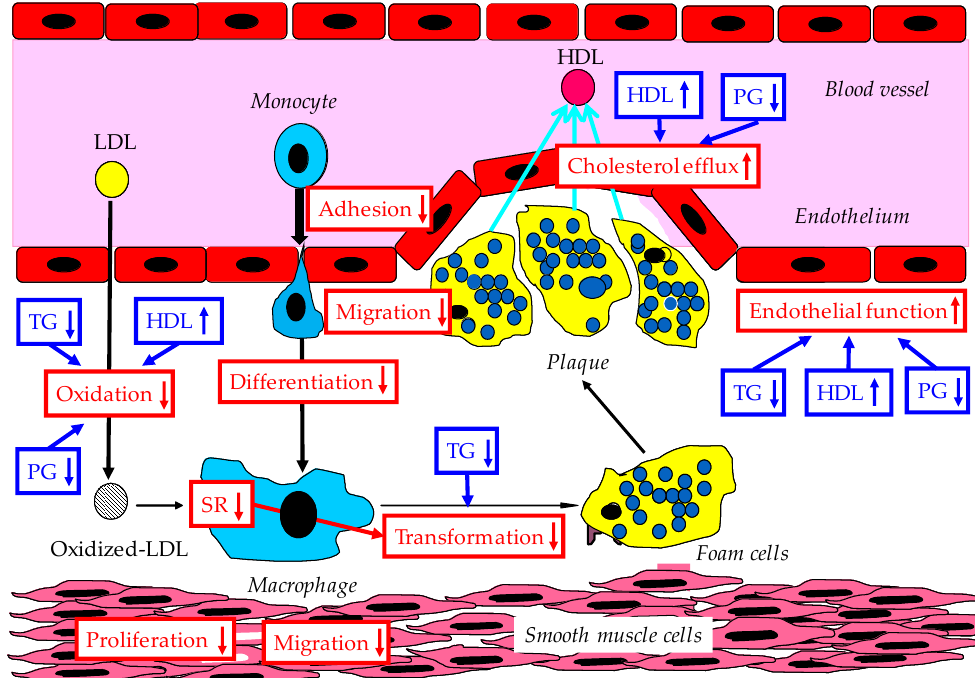
Figure 3. Possible anti-atherosclerotic effects of adiponectin and improvement of lipid/glucose metabolism by adiponectin. The red words in the red squares show the anti-arteriosclerotic effects of adiponectin. HDL, high-density lipoprotein; LDL, low-density lipoprotein; PG, plasma glucose; SR, scavenger receptor; TG, triglyceride.